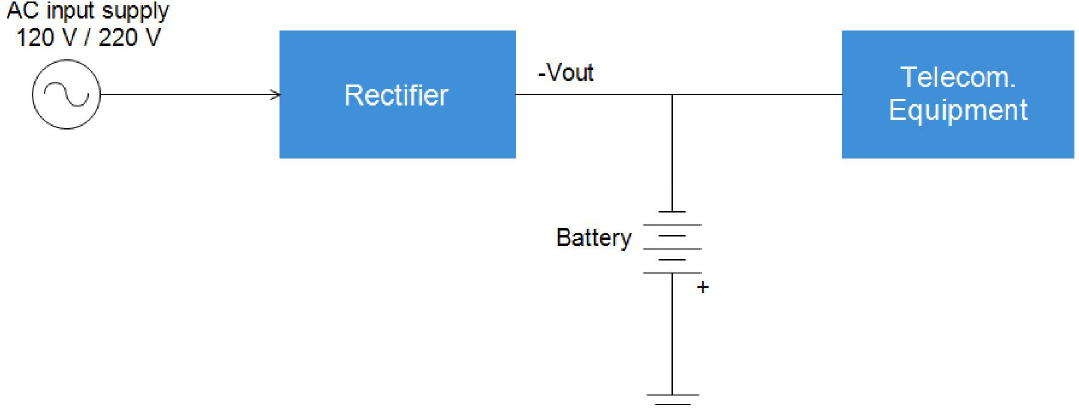
FIG. 2. GENERIC ARCHITECTURE OF POWER SUPPLY TO TELECOM